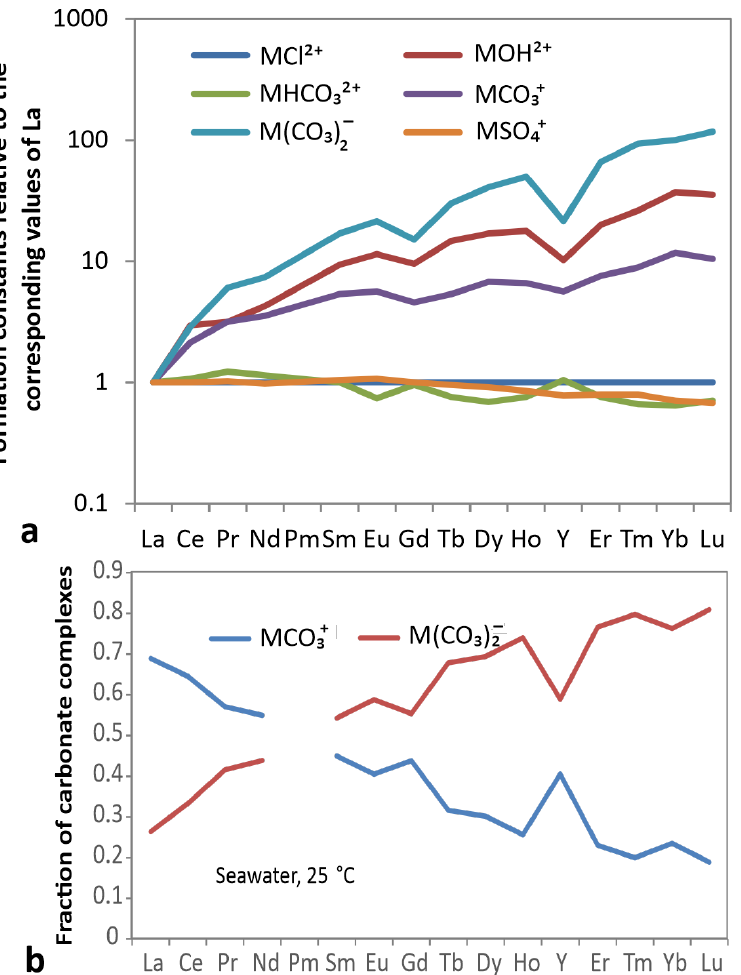
Figure 1. Formation constants and speciation in seawater at 25 ◦ C. ( a ) All patterns of formation constants are normalized to their corresponding La values. M refers to REY. References for formation constants are cited in the text. ( b ) A fraction of the most important REY species in seawater at 25 ◦